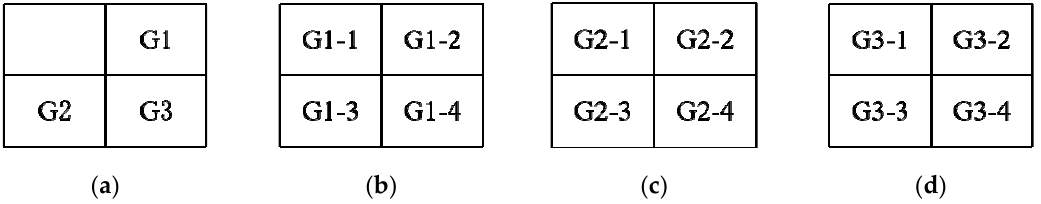
Figure 10. Haar wavelet and the block of each sub-blocks: ( a ) Haar wavelet; ( b ) Sub-block distribution of G1; ( c ) Sub-block distribution of G2; ( d ) Sub-block distribution of G3.